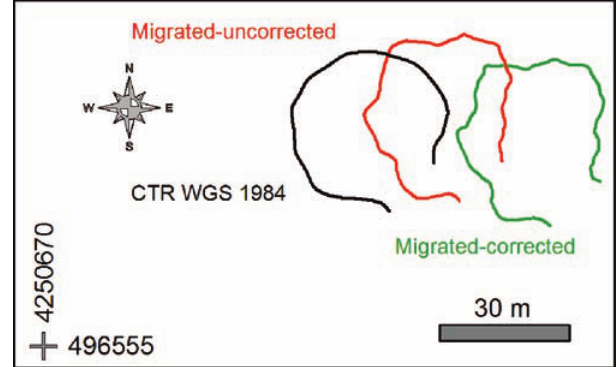
Figure 8. Relative positions of the flat bottom of the La Fossa crater from the CTR map georeferenced in WGS 1984 (black line), the uncorrected Gauss Boaga map converted in WGS 1984 (red line), and the uncorrected Gauss Boaga map corrected using the formulae presented in this study (green line).